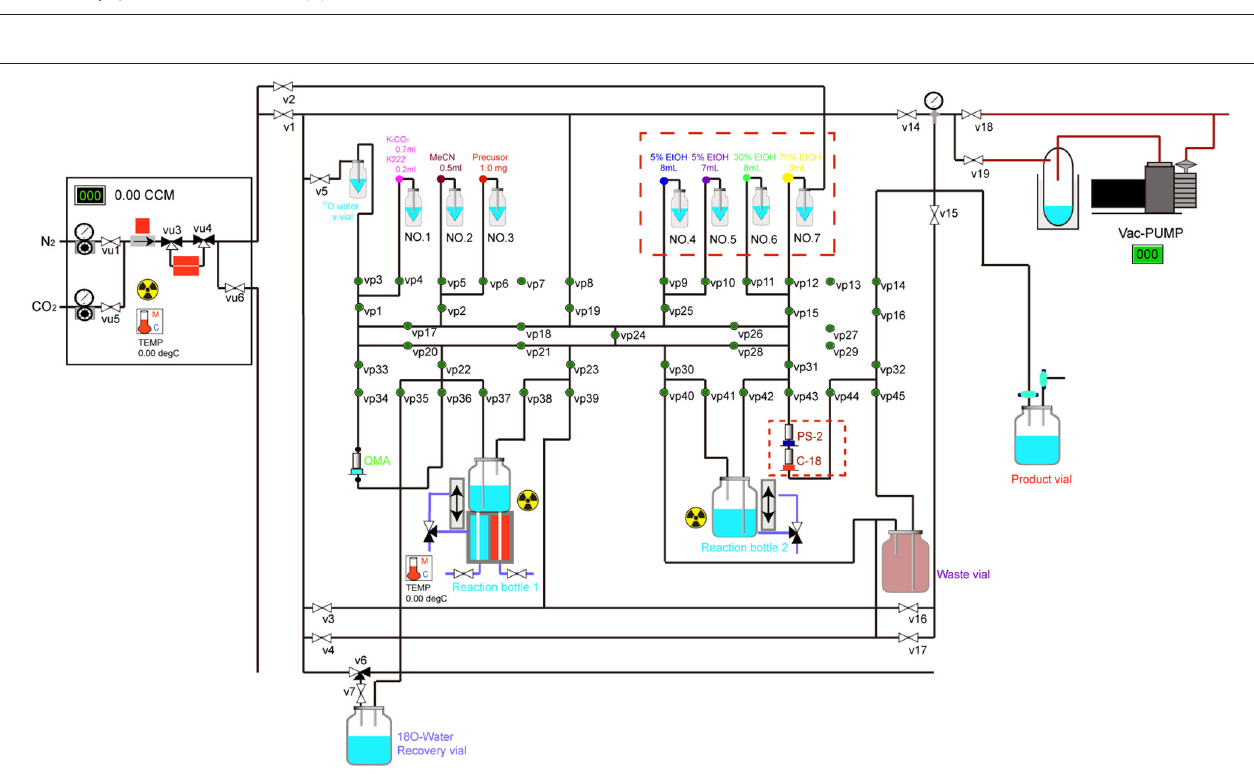
FIGURE 2 | Diagram of the automated system of radiosynthesis of 18 F-FP-( + )-DTBZ.